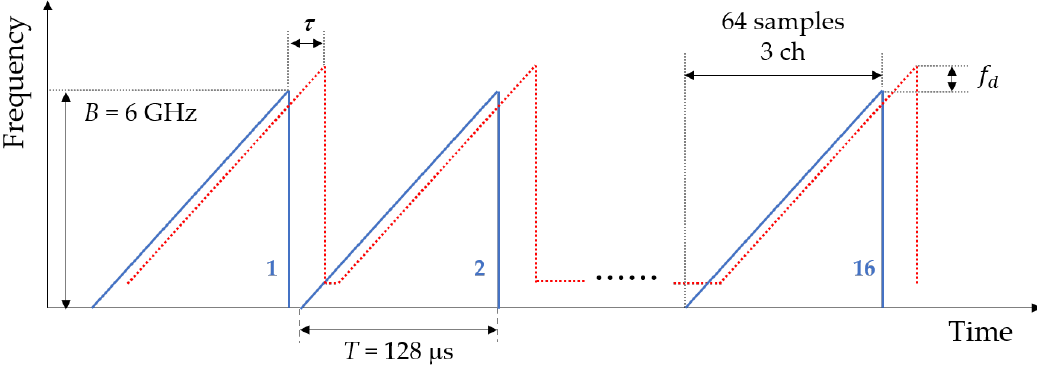
Figure 1. Frequency modulated continuous wave (FMCW) waveform in the frequency domain for a shape group.